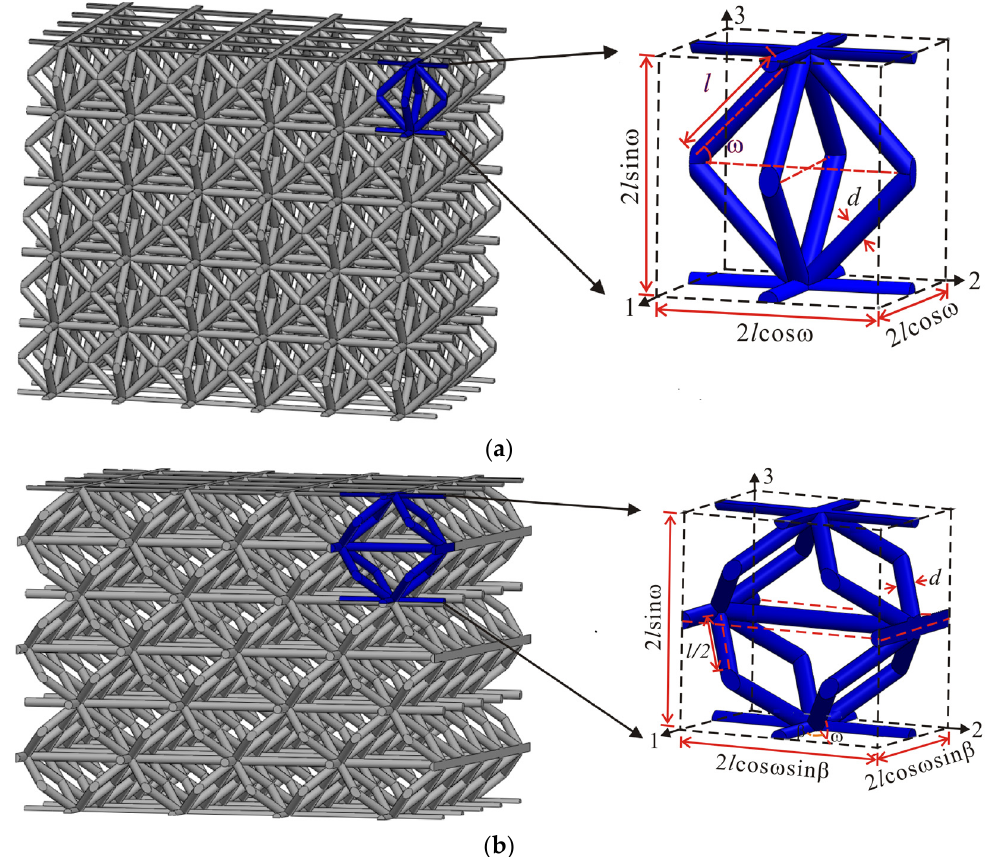
Figure 1. Geometric diagram and actual image of two designed architecture materials: ( a ) the unit cell of FCC lattice; ( b ) the unit cell of X-type lattice.